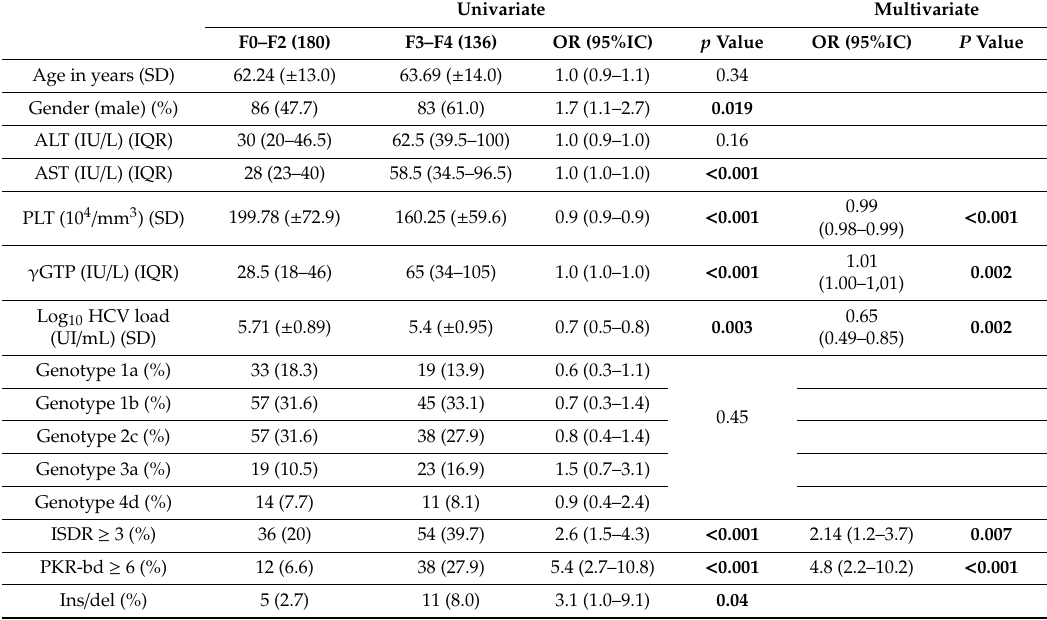
Table 1. Univariate and multivariate analysis of factors associated with high fibrosis levels.